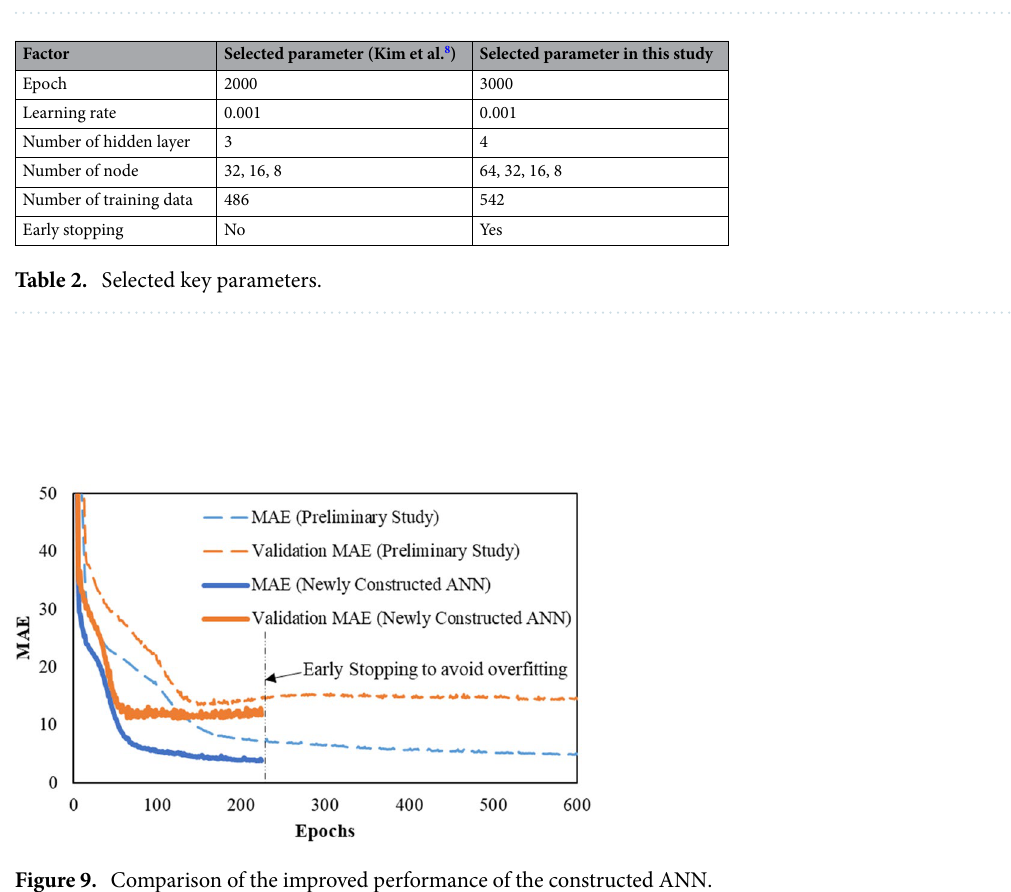
Figure 8. Loss and MAE depending on the number of layers.